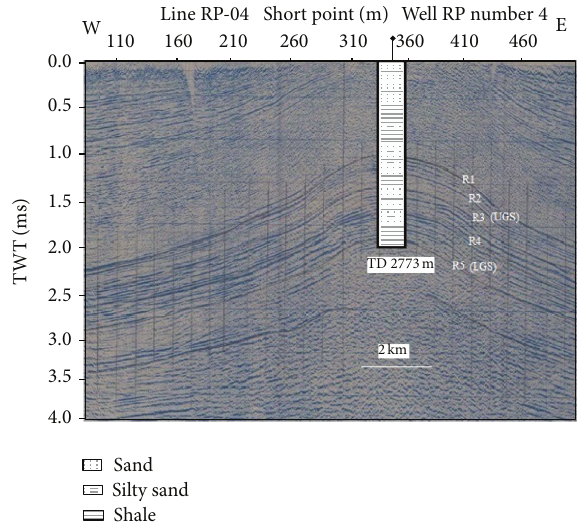
Figure 4: Geologic correlation between seismic sections at line RP- 04 in the well RP #4 of Rashidpur structure.